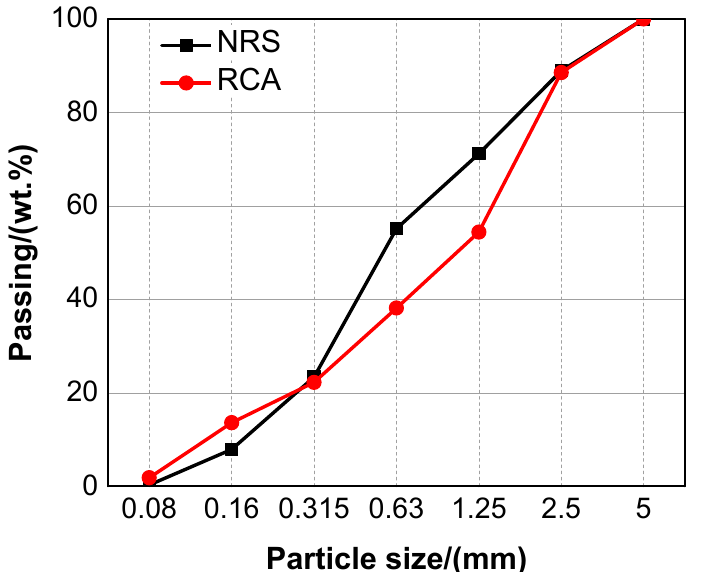
Figure 2. Sieve analysis of the natural river sand and fine RCA.